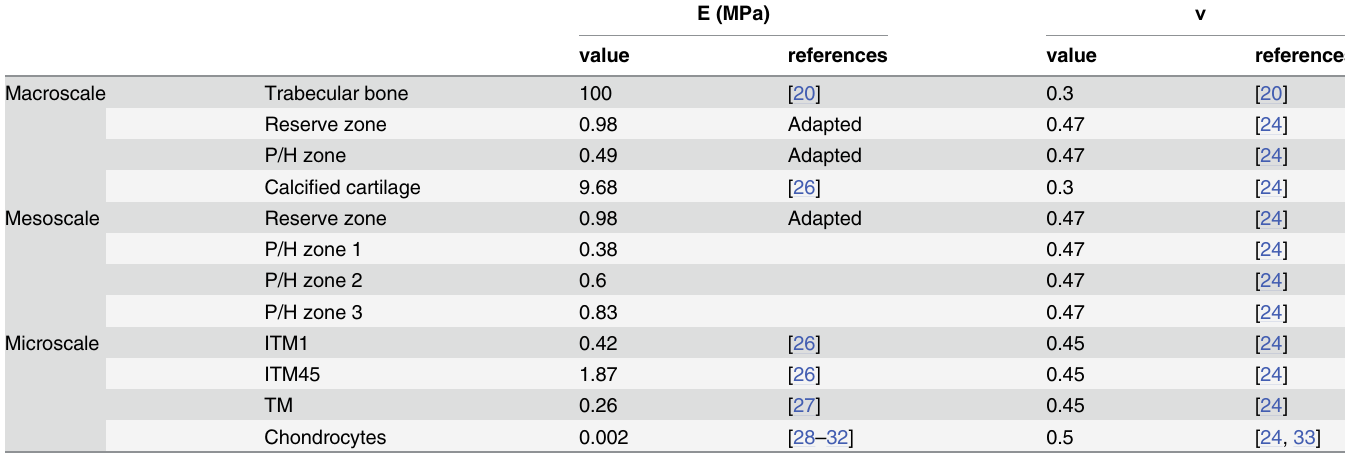
Table 1. Young ’ s modulus (E) and Poisson ’ s ratio ( ν ) of the growth plate components used in the multi-scale